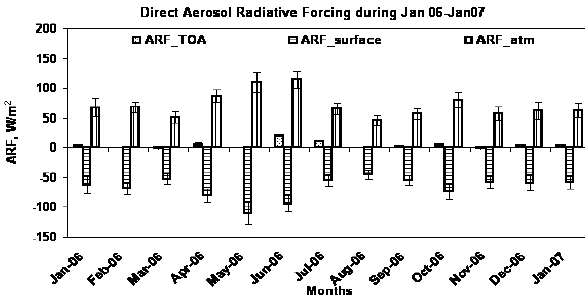
Fig. 8. Variation of monthly averages of clear-sky direct aerosol radiation forcing (DARF) over TOA, surface and in the atmosphere during January 2006 to January 2007 over Delhi.